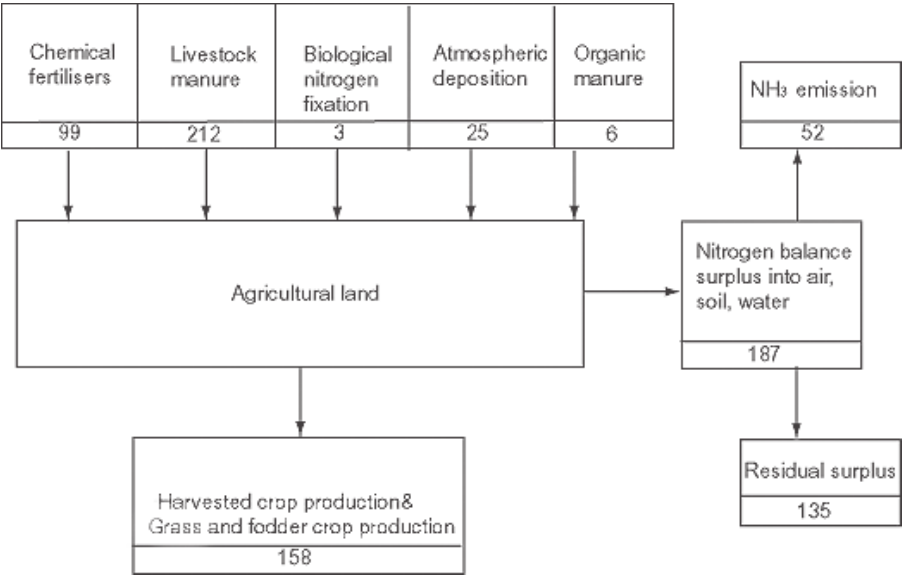
FIGURE 1. Soil surface balance of Flemish agriculture in 1998 in millions kg N[2 ]